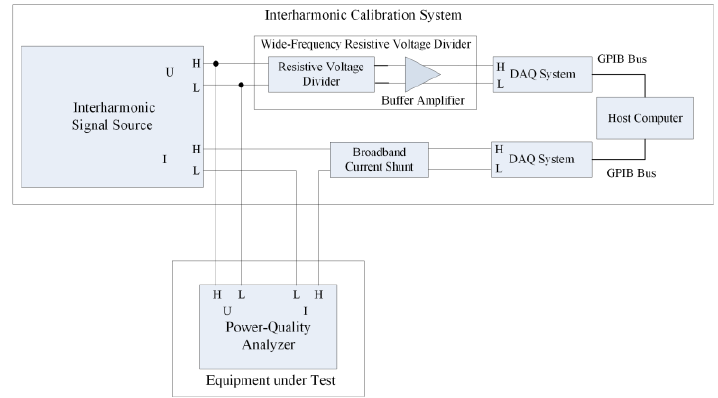
Figure 1. Diagram of the interharmonic calibration system.